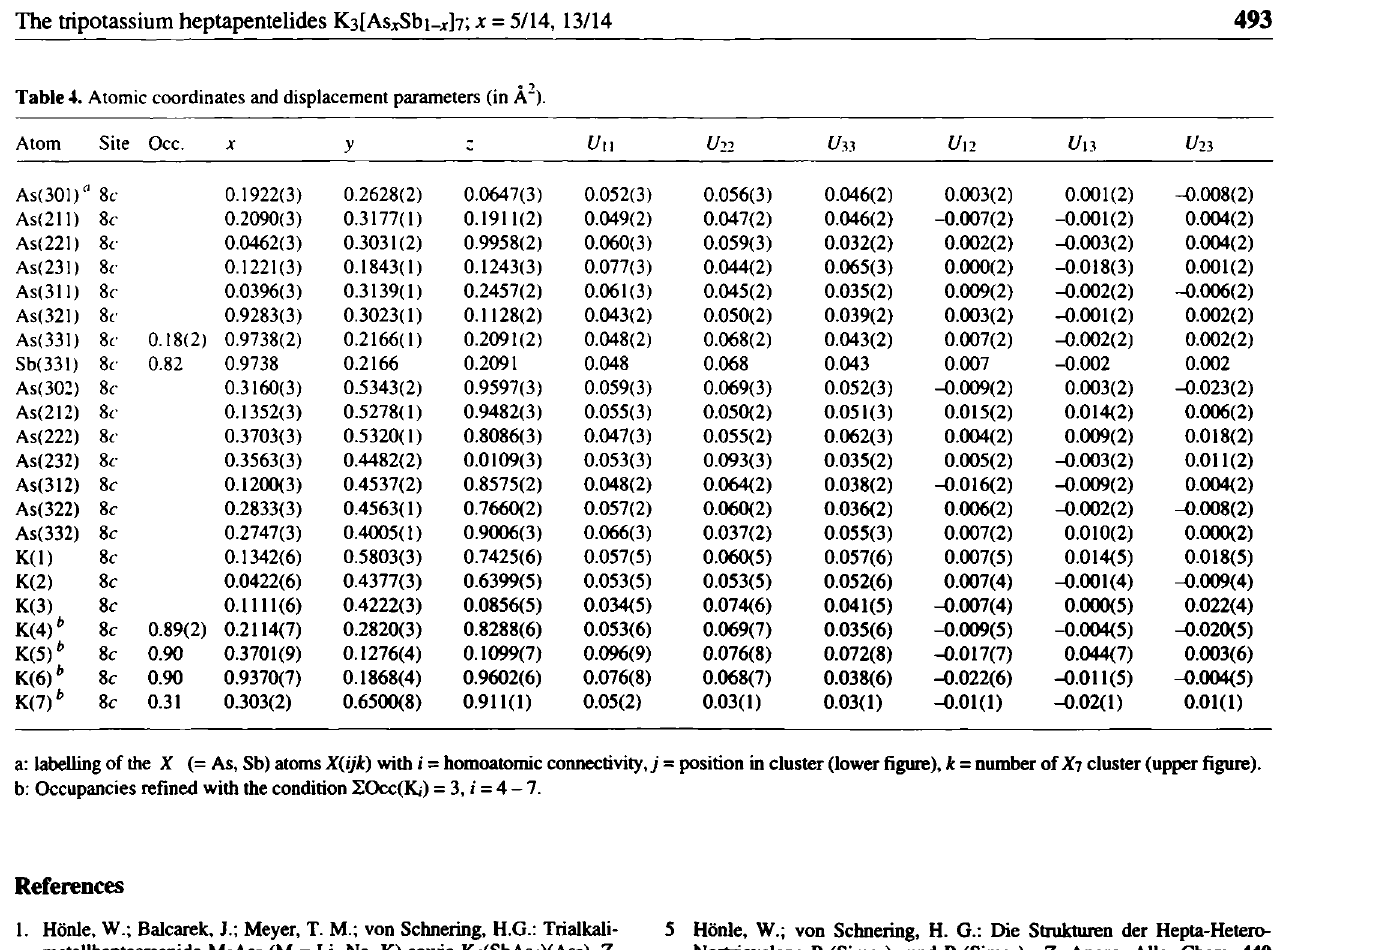
Table 4. Atomic coordinates and displacement parameters (in Â 2